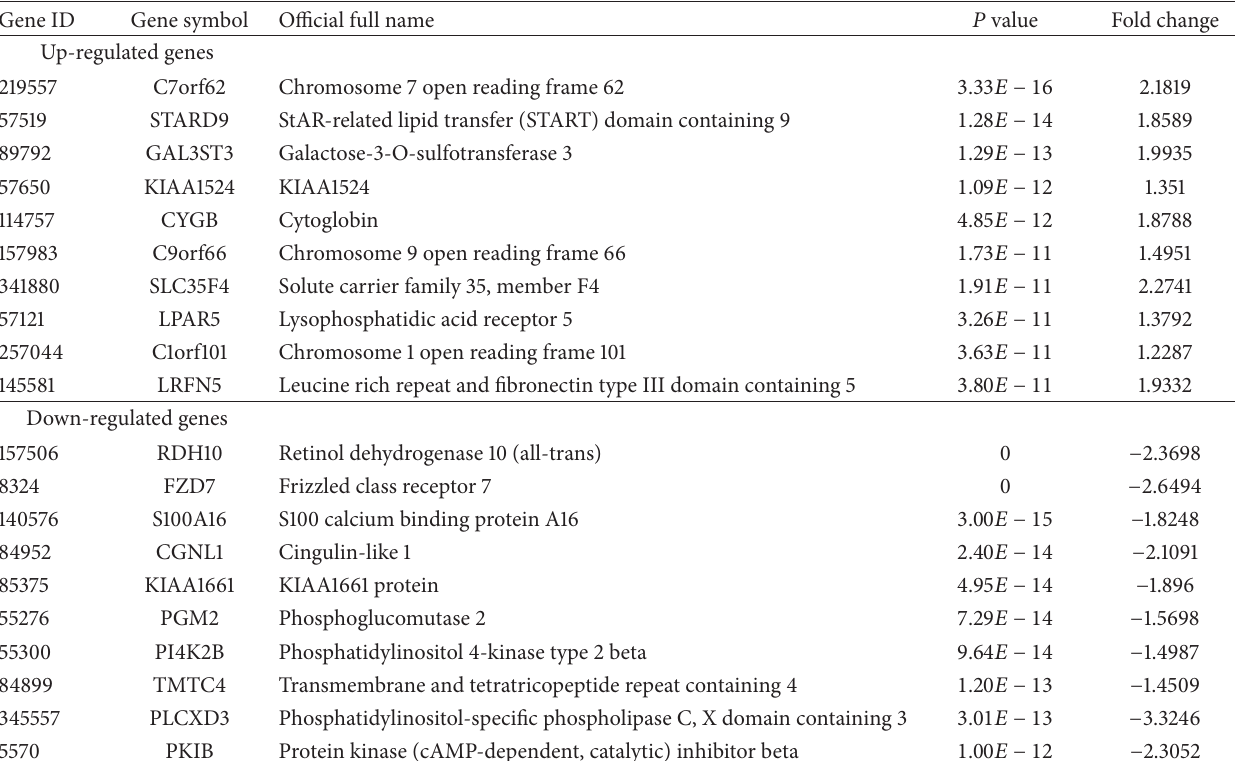
Table 2: The top 10 most significantly up- or down-regulated DEGs.